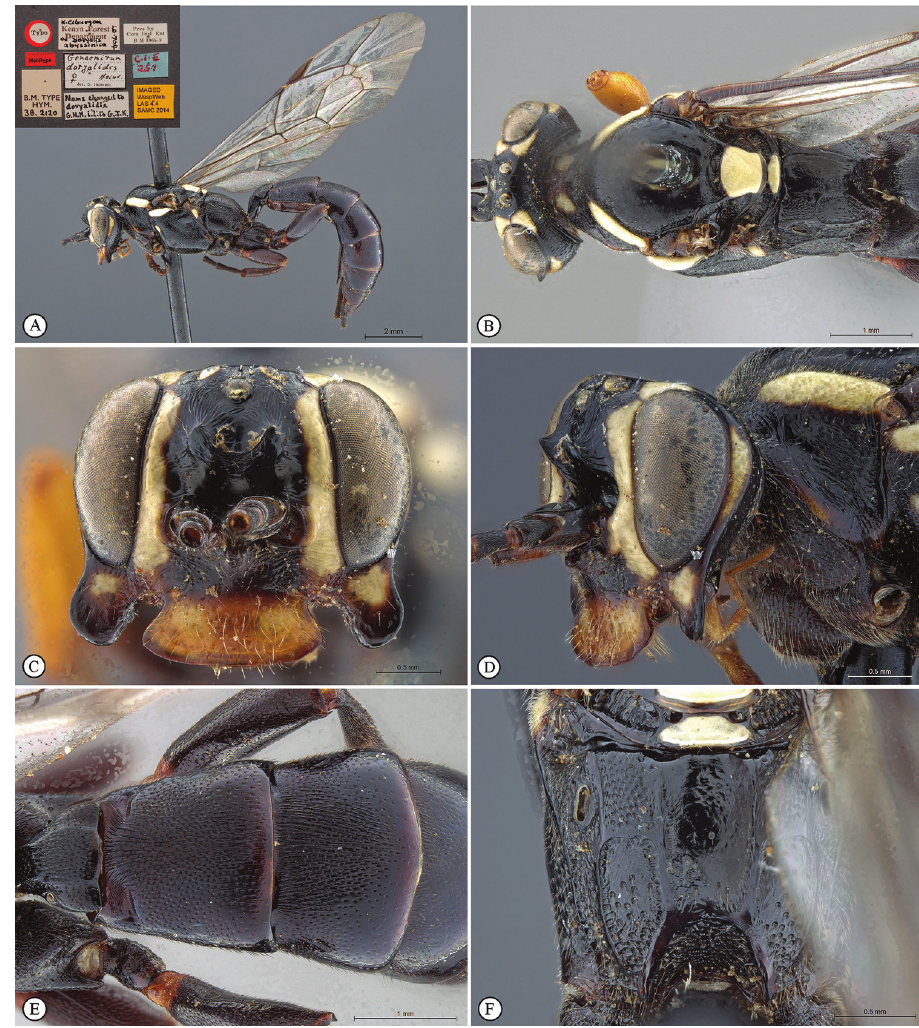
Figure 5. Genaemirum doryalidis Heinrich. Holotype female. A habitus lateral view (inset: data labels) B head, mesosoma, dorsal view C head anterior view D head, mesosoma anterior-lateral view E metasomal tergites 1-4 dorsal view F propodeum, dorsal